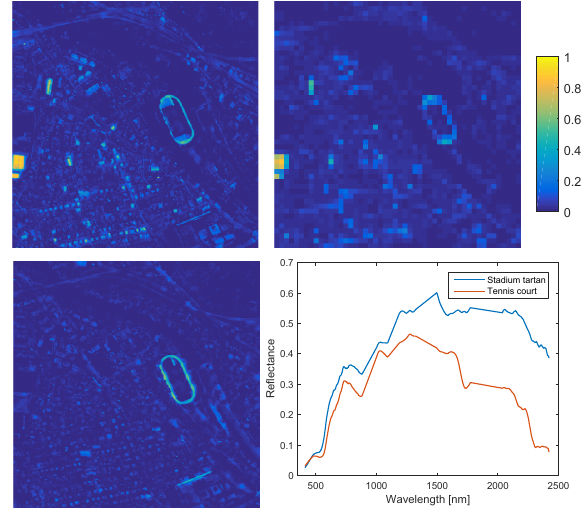
Figure 5. Top row: Abundance maps corresponding to the end- member of a tennis court surface: for the fused image (left), for the HSRI (right). Bottom row: Abundance map for the fused image corresponding to the stadium tartan endmember (left), the ground truth spectra of the respective materials